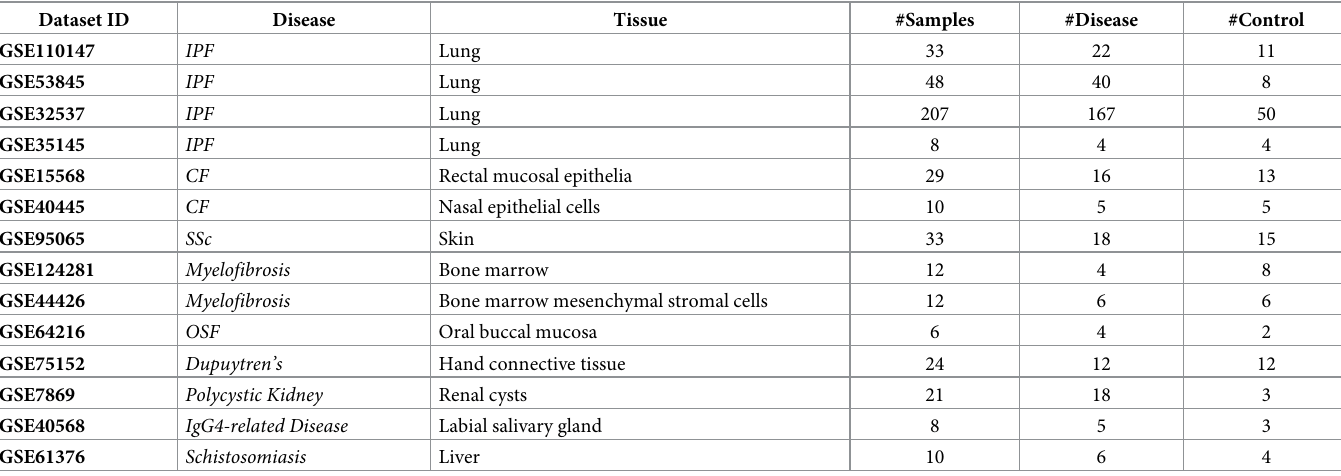
Table 1. Dataset information regarding the GEO microarray experiments. Dataset